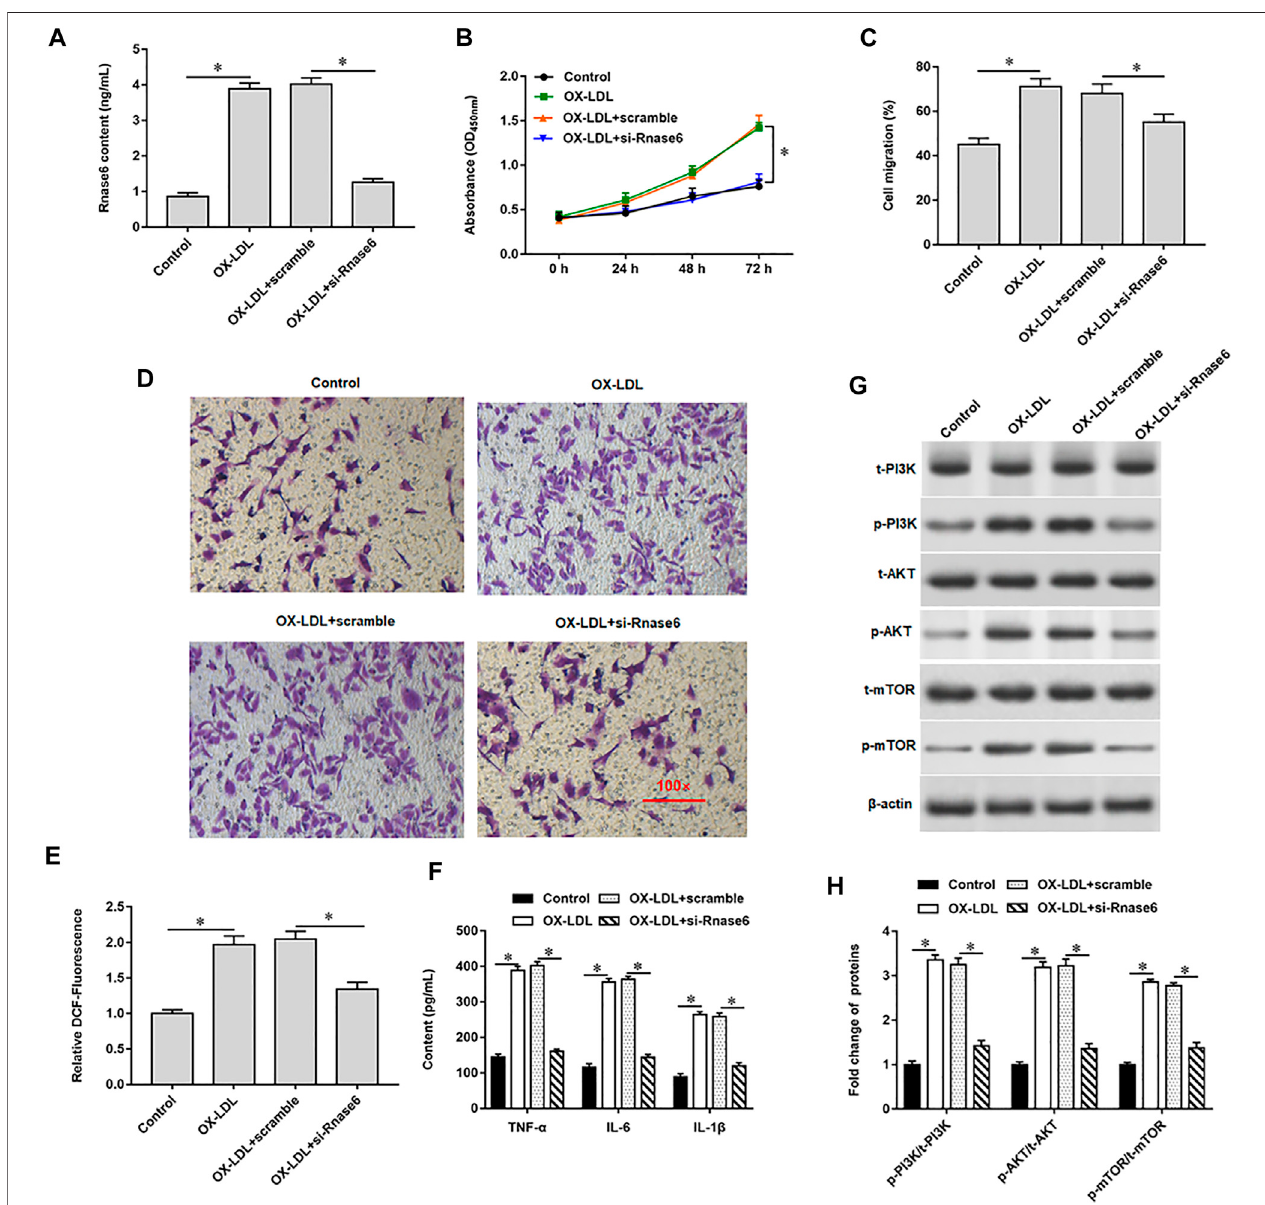
FIGURE 2 | Interference with Rnase6 expression inhibited OX-LDL-induced proliferation and migration of MOVAS cells. MOVAS cells were induced with OX-LDL for48 h,andscrambleorsi-Rnase6(30 nM)weretransfectedinthecells,respectively. (A) .RelativeexpressionofRnase6wasdetectedbyELISA. (B) .CCK-8assaywas usedtoanalyzedtheproliferationofMOVAScells. (C,D) . Trans -wellassaywasusedtomeasurethecellmigration. (E). ELISAwasusedtodetectthecontentofROS. (F) . Relative secretion levels of TNF- α , IL-6 and IL-1 β were analyzed by ELISA kits. (G,H) . Fold change of signaling pathway-related proteins in cells were analyzed by Western blotting. β -actin was used as an internal reference. N (cid:2) 6, * p < 0.01.